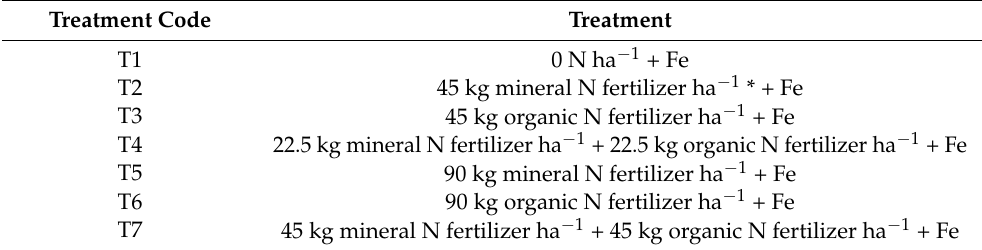
Table 2. Treatments applied to determine the influence of N on maize and finger millet grain yield and Fe